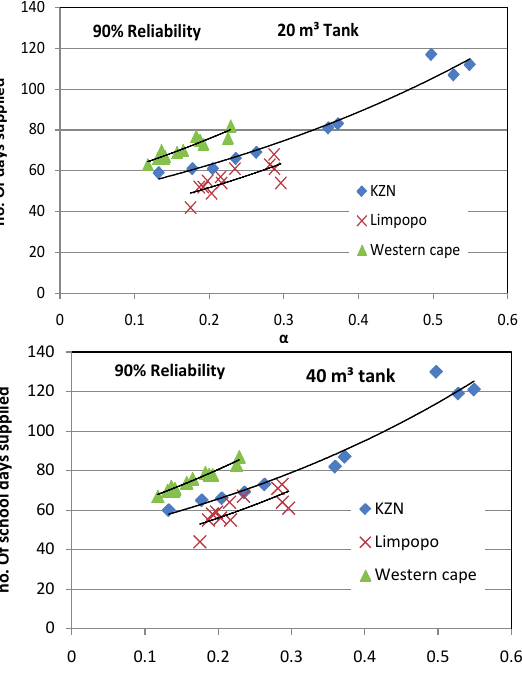
Fig. 4 Generalized relationships between supply to demand ratio ( α ) and number of days